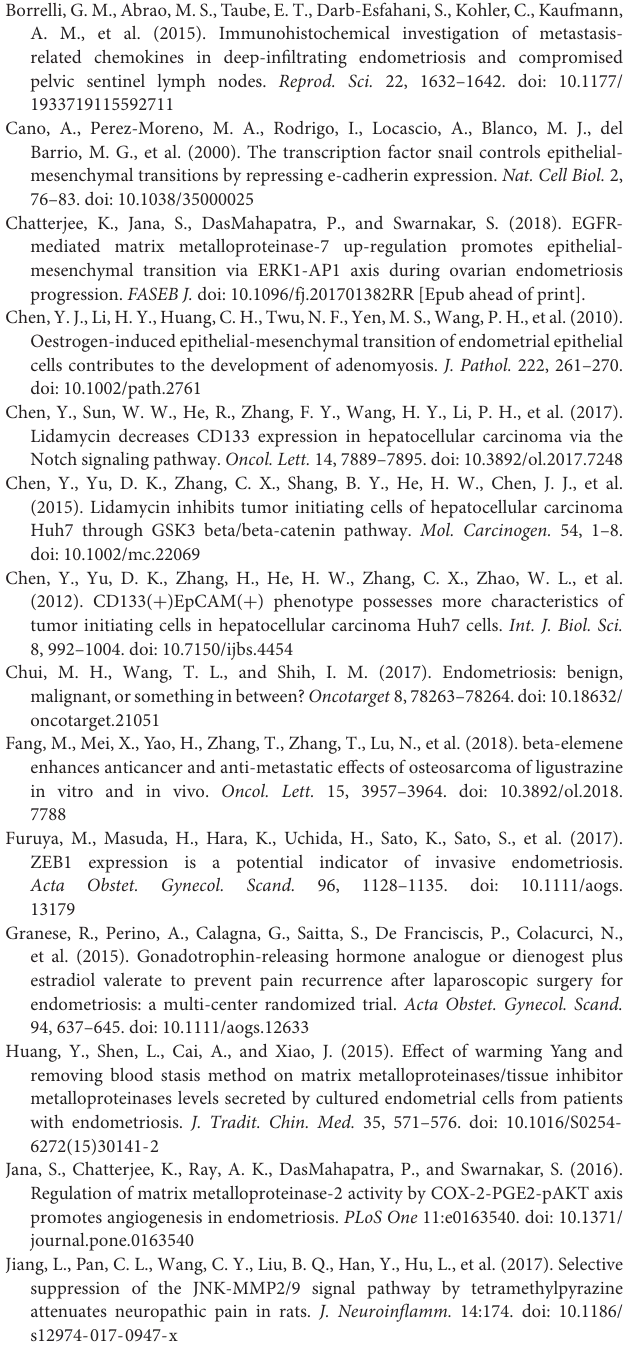
TABLE S1 | Detail and interaction information of targets for JFS compounds. TABLE S2 | EMS-related targets and interaction information with JFS-related targets. TABLE S3 | 22 common targets obtained from JFS-related targets and EMS-related targets.